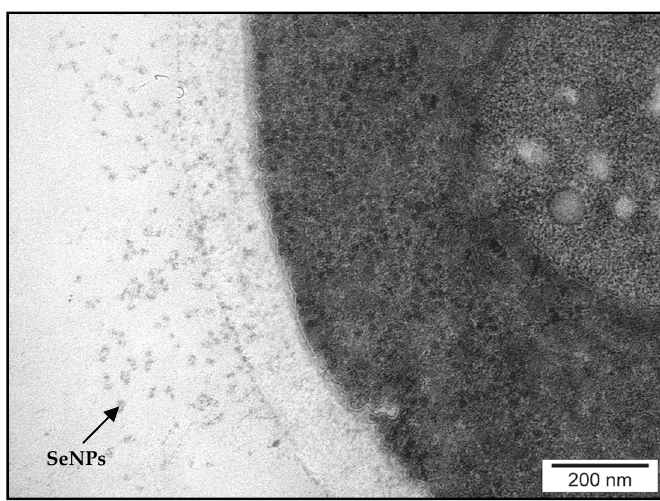
Figure 7. Size distribution of SeNPs.